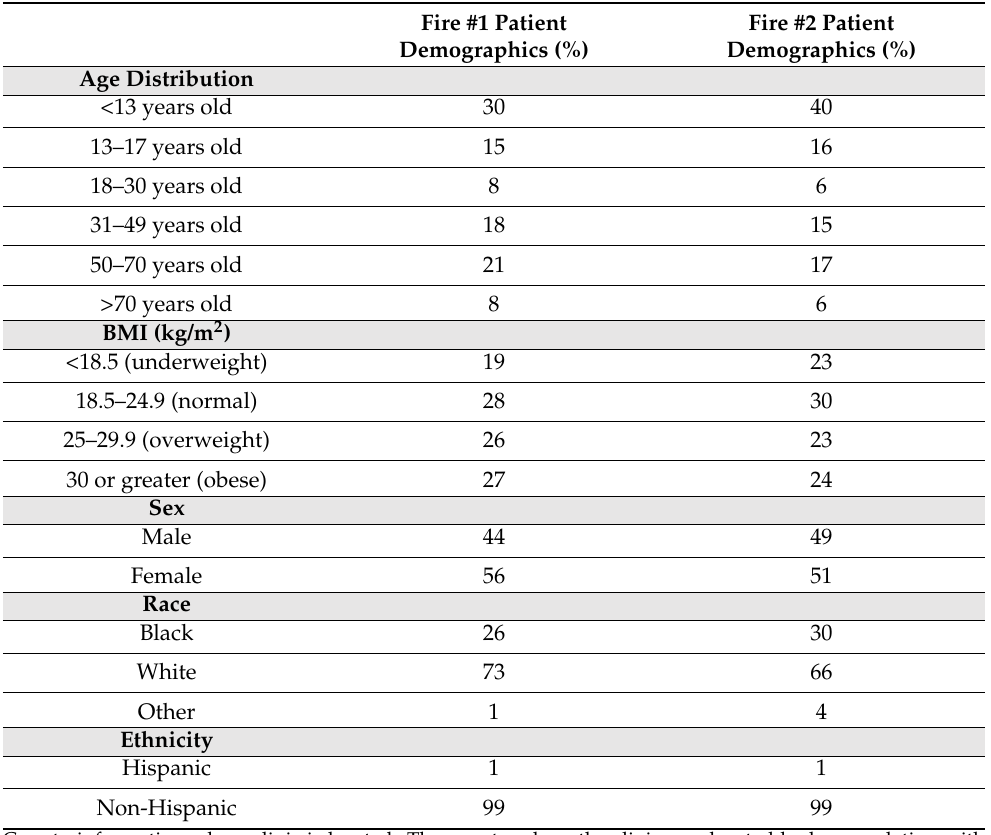
Fire #1 Patient Demographics (%)